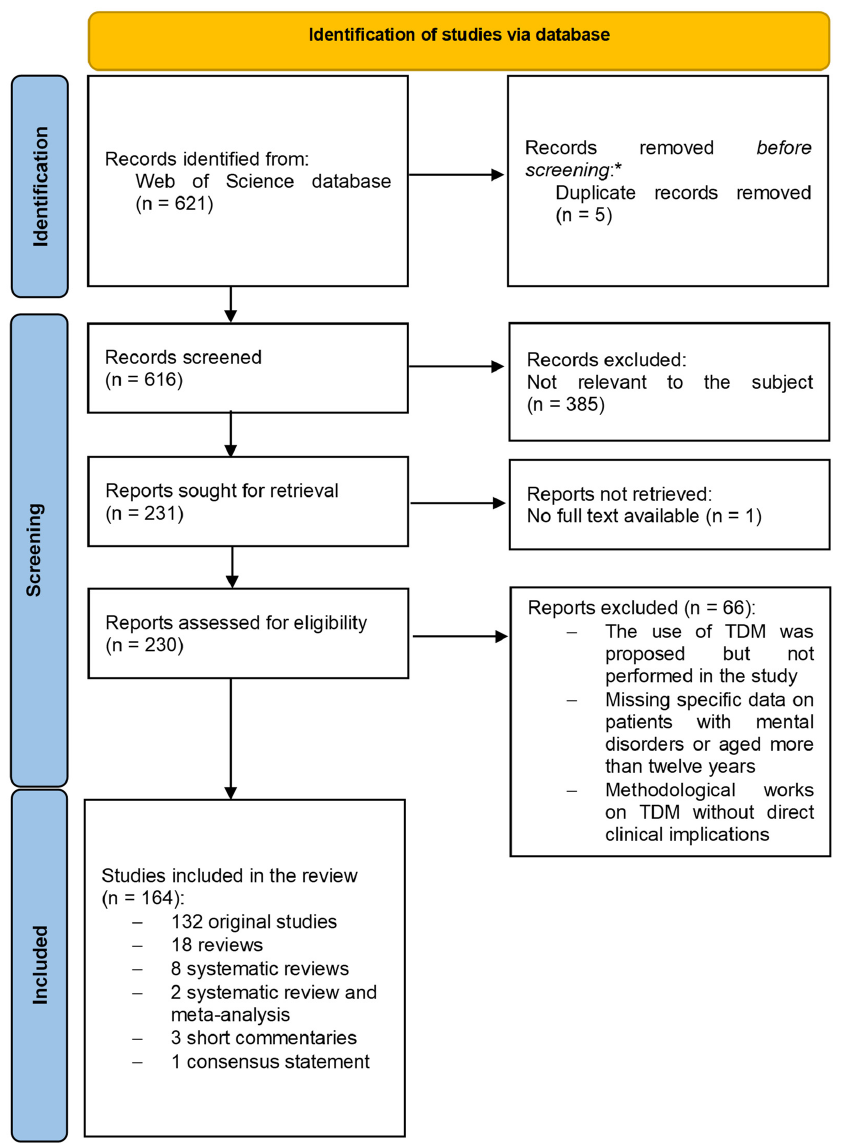
Figure 1. Identification and screening procedure of the studies included. * No automation tools were used.